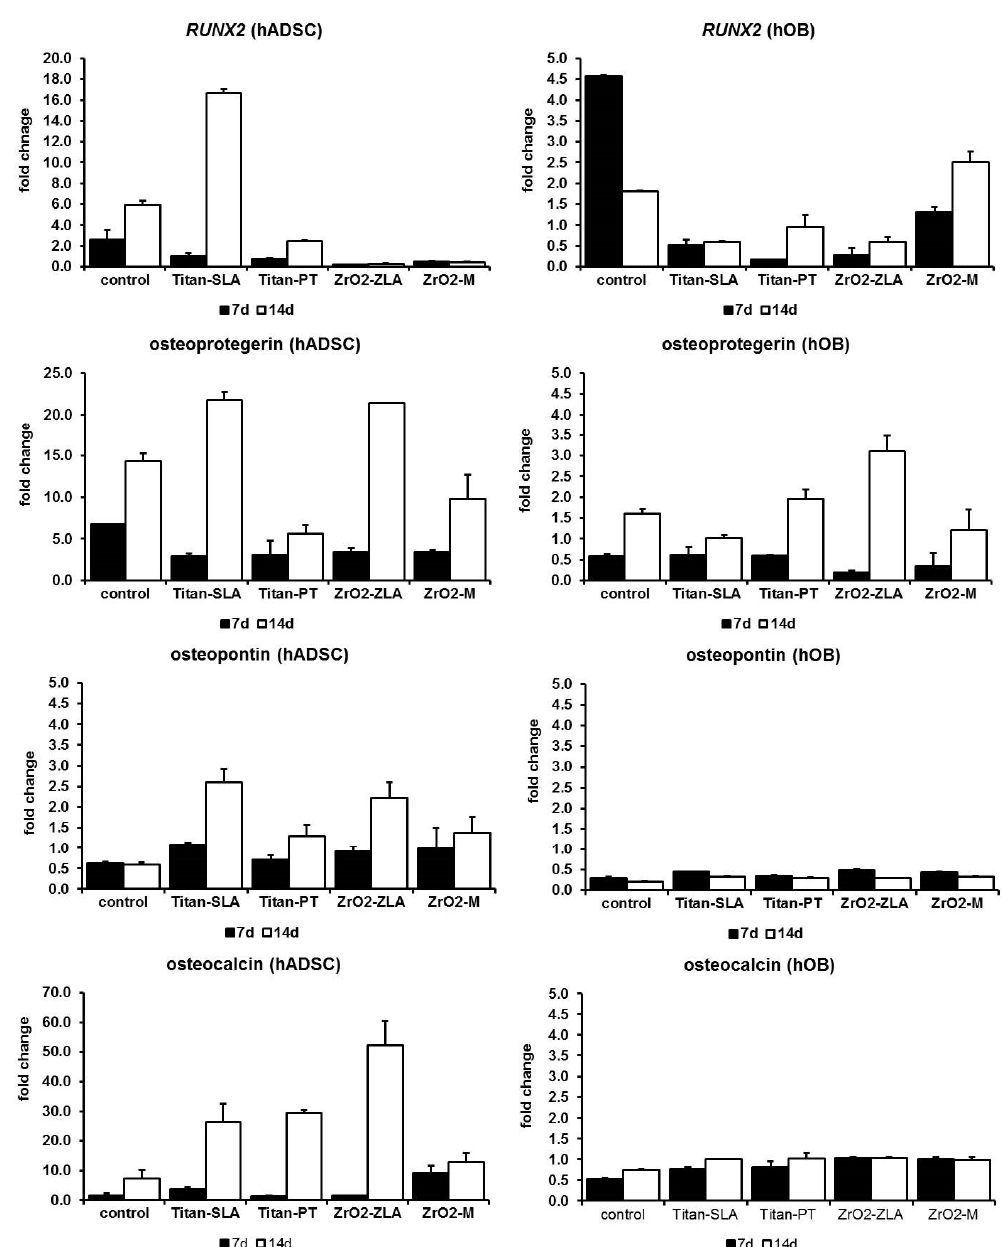
Figure 3. Fold change of osteogenic markers compared to day 1 ( RUNX2 p = 021 for hADSC, p = 0.135 for hOB; osteoprotegerin p = 0.011 for hADSC, p = 0.008 for hOB; osteopontin p = 0.07 for hADSC, p = 0.024 for hOB, osteocalcin p = 0.024 for hADSC, p = 0.25 for hOB; standard abbreviation as error marks).